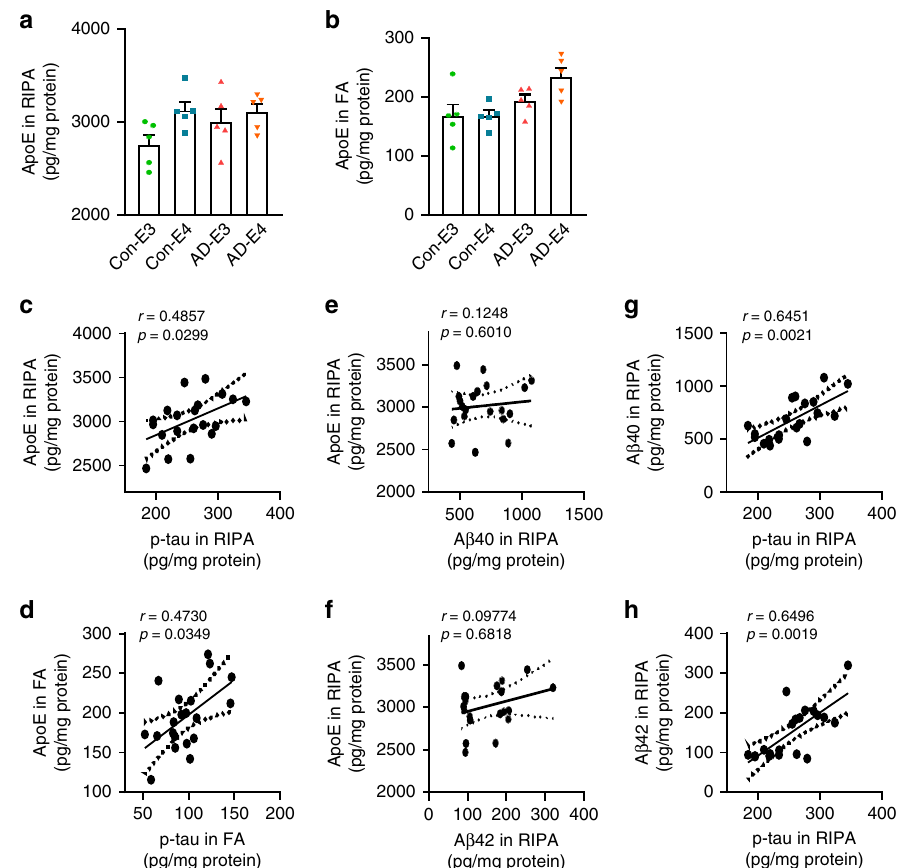
Fig. 5 Positive correlation between apoE and p-tau levels in the iPSC-derived cerebral organoids. a , b Amounts of apoE in the RIPA fraction ( a ; APOE4: p = 0.0322, AD: p = 0.3691, APOE4 x AD: p = 0.4301) and the FA fraction ( b ; APOE4: p = 0.641, AD: p = 0.0244, APOE4 x AD: p = 0.4023) of 4 – 5 cerebral organoids per line were measured by ELISA at week 12. Data were normalized to individual total protein concentration. All data are expressed as mean ± SEM ( N = 5). ANCOVA for APOE4 , AD status, and APOE4 x AD status was performed by including sex, sampling age, and source of iPSCs as co- variables, which was followed by two-sided Tukey – Kramer tests to compare between the groups with two factors ( APOE4 and AD status). c – h Two-sided Spearman correlation analysis (before adjustment) of apoE vs. p-tau in RIPA ( c ) and FA ( d ) fractions, apoE vs. A β 40 ( e ) or A β 42 ( f ) in RIPA fraction, and p-tau vs. A β 40 ( g ) or A β 42 ( h ) in RIPA